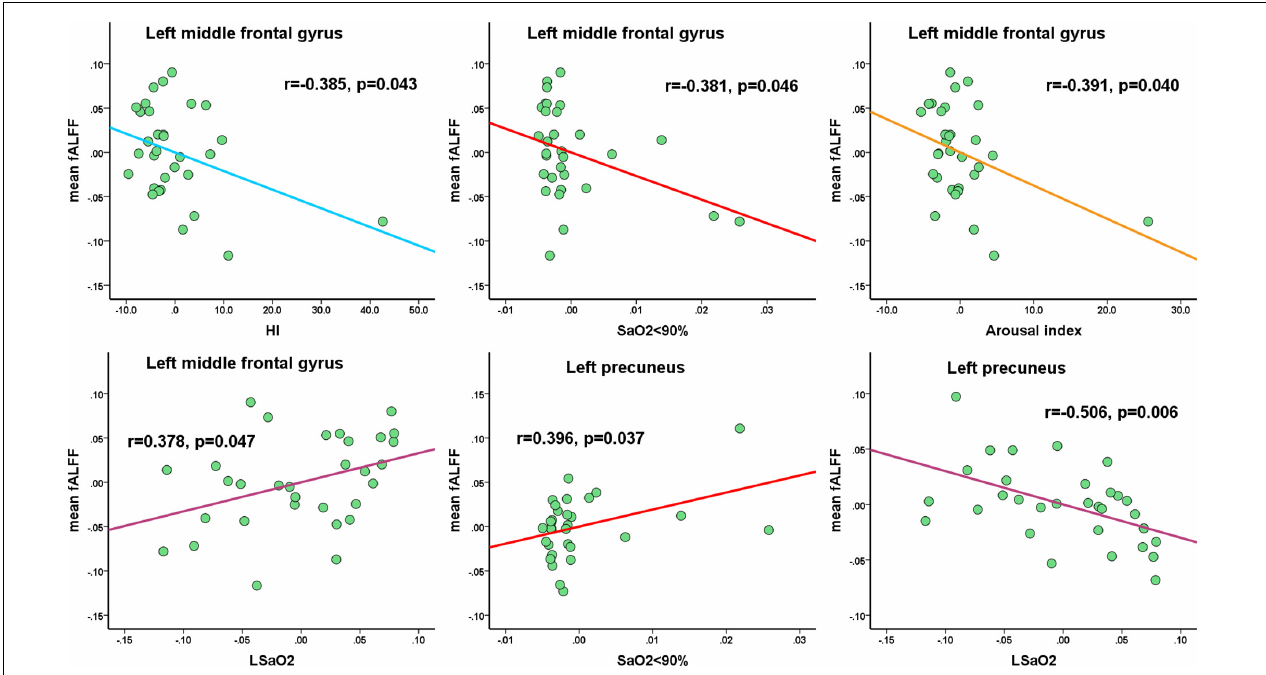
FIGURE 5 | The mean fALFF values in altered clusters show the significantly partial correlations with clinical parameters. Of note, the coordinate value of both X -axis (clinical parameter) and Y -axis (fALFF value) do not reflect the initial values of these variables, while considering age, gender and FD as covariates. All the p -values were uncorrected for multiple